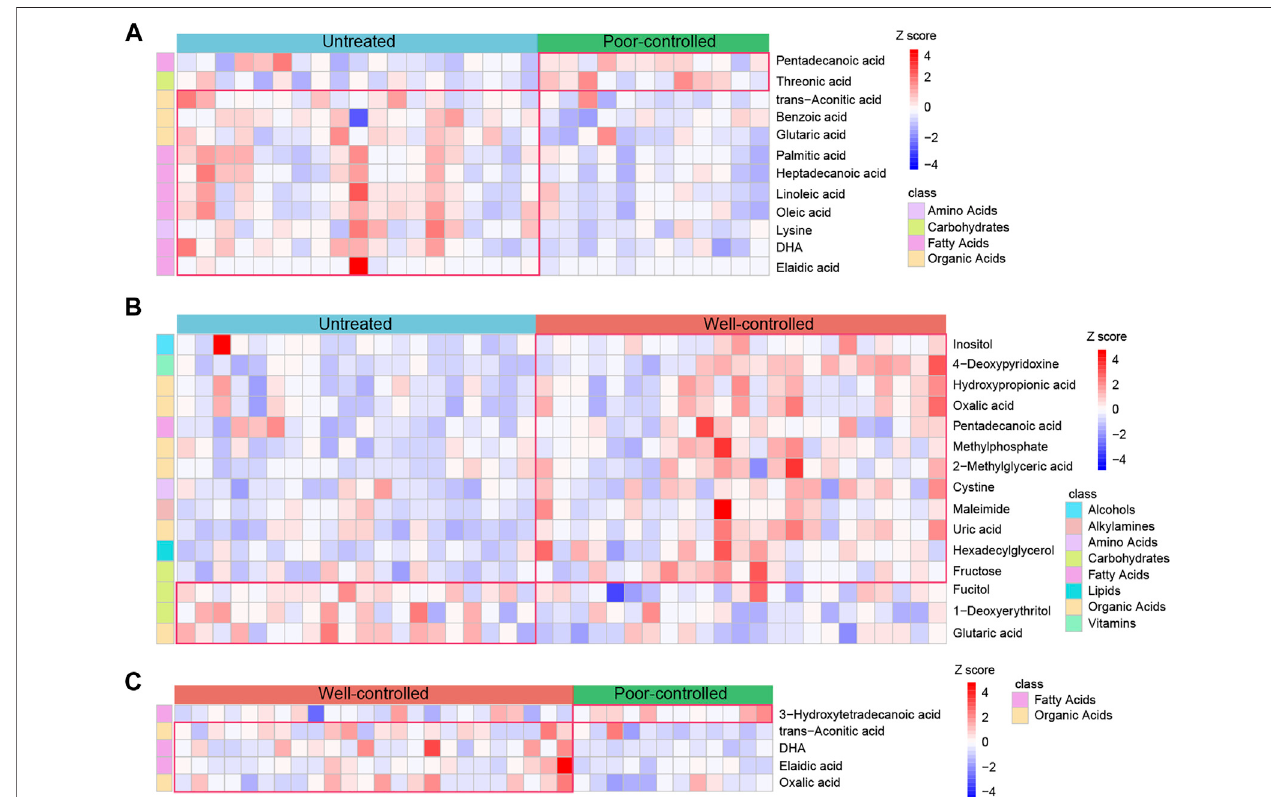
FIGURE 6 | Abundance of the serum metabolites in untreated, ACEI/ARB well-controlled, and ACEI/ARB poor-controlled groups. (A) Heat map for the relative abundanceofstrikinglydecreasedandsigni fi cantlyenrichedserummetabolitesinpoor-controlledpatientswhencomparedwithuntreatedones.Themetabolitesshown are statistically signi fi cant in the calculation, and the relative abundance is shown in each sample. (B) Heat map illustrating the relative abundance of shifted serum metabolites between untreated and ACEI/ARB well-controlled groups. (C) Heat map demonstrating the relative abundance of statistically shifted distinct serum metabolites between the poor-controlledand well-controlled groups. The abundance pro fi les aretransformed intoZ-scores bysubtracting the average abundance and dividing the standard deviation of all the samples. Z-score is negative and shown in blue when the abundance is lower than the mean and is positive and shown in red when the relative abundance is higher than the